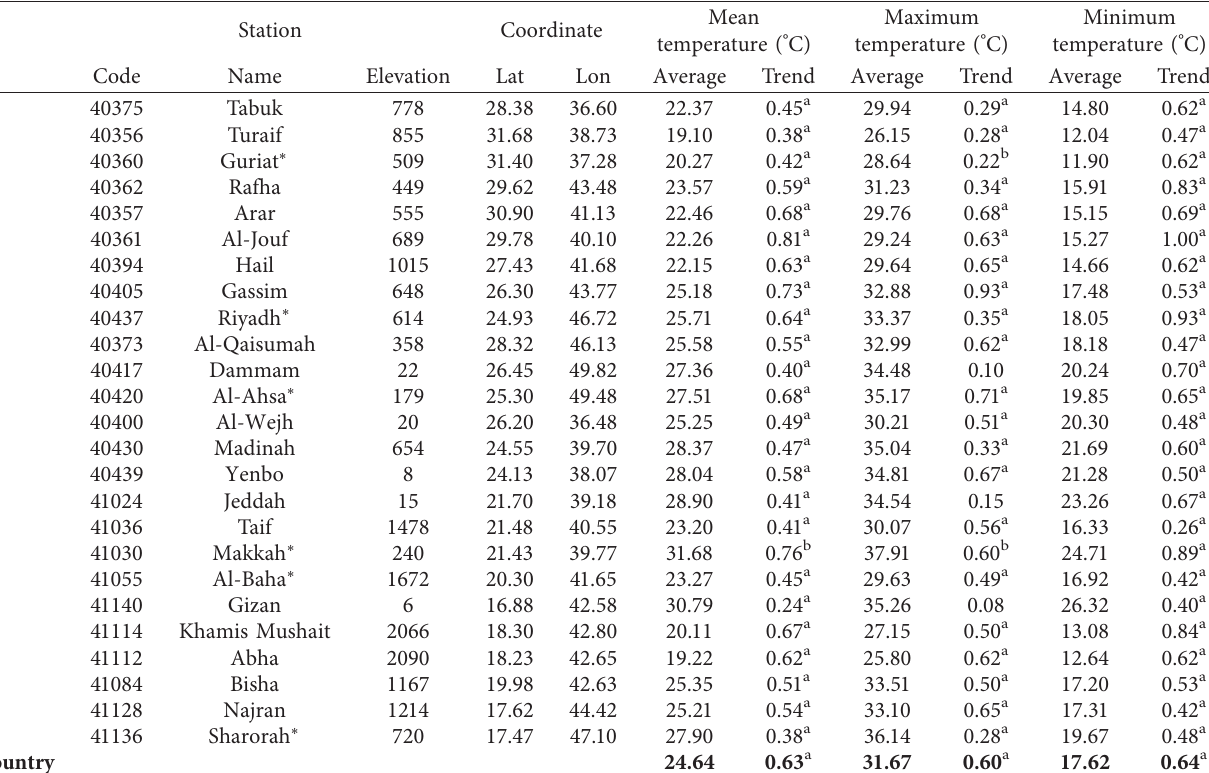
Table 1: Station names, elevation (in meters), and geographic locations (latitude degree N and longitude degree E) in Saudi Arabia along with temperatures ( ° C) and their linear trends ( ° C per decade) for the period 1978–2019. Sr.